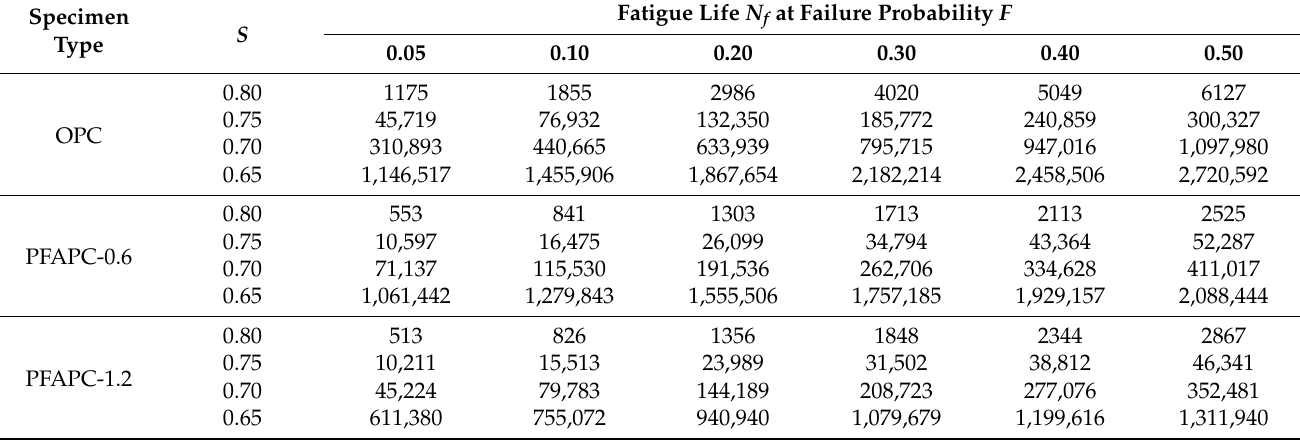
Table 8. Equivalent fatigue life calculation